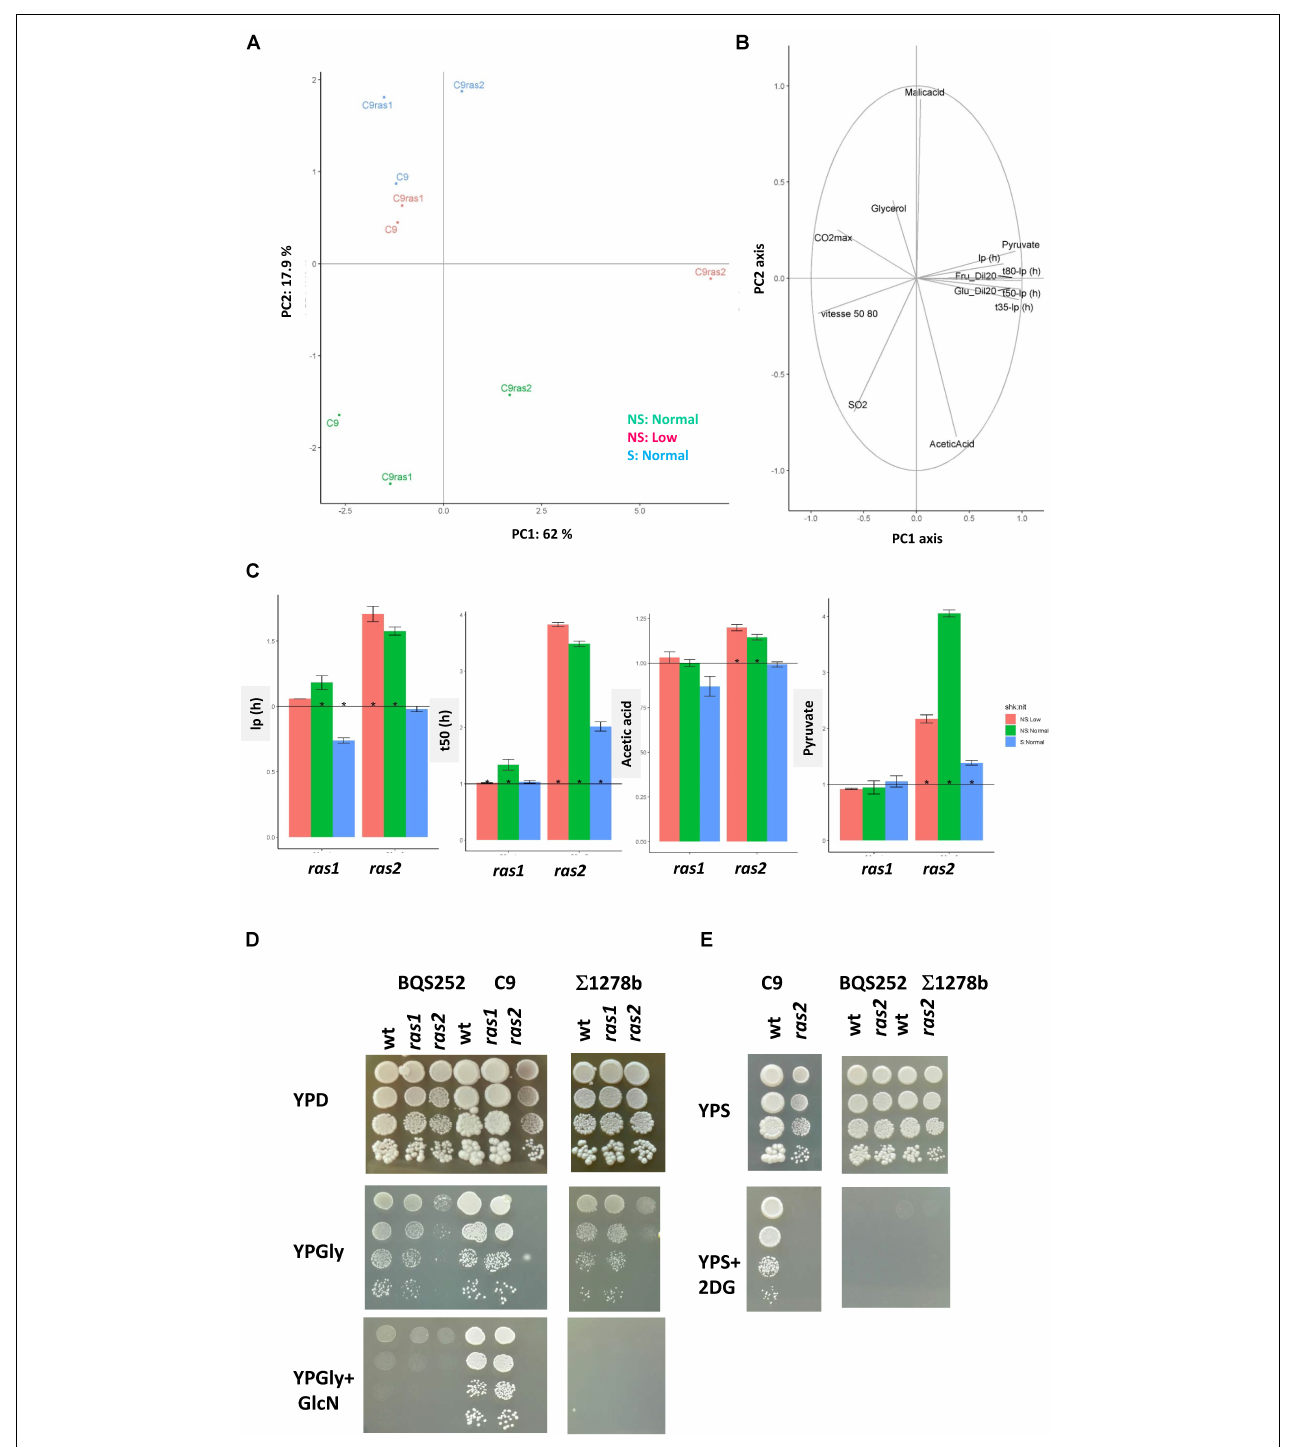
FIGURE 6 | Ras2 had a profound impact on wine fermentation, respiration and glucose repression. (A) The PCA analysis of mutants ras1 (cid:49) and ras2 (cid:49) and parental strain C9 in the three fermentations: NS:Normal (green), NS: Low (red) and S:Normal (blue). (B) The correlation circle of the used kinetic and enological parameters. (C) Diagrams showing the relative values of lp, t50-lp (h), acetic acid, and pyruvate of mutants ras1 (cid:49) and ras2 (cid:49) in relation to parental strain C9. Fermentations were carried out in triplicate, and average and standard deviations are shown. Significant differences ( p < 0.05) are marked by ∗ . (D) The spot analysis of mutants ras1 (cid:49) and ras2 (cid:49) in three genetic backgrounds, BQS252, C9, and (cid:54) 1278b in rich medium YPD, respiratory medium YPGlycerol (YPGly) and YPGlycerol with 0.05% glucosamine (GlcN), to test glucose repression. (E) The spot analysis of mutant ras2 (cid:49) in the same genetic backgrounds grown in YP Sucrose (YPS) and YP sucrose + 100 µ g/ml 2-deoxyglucose (2DG) to test glucose